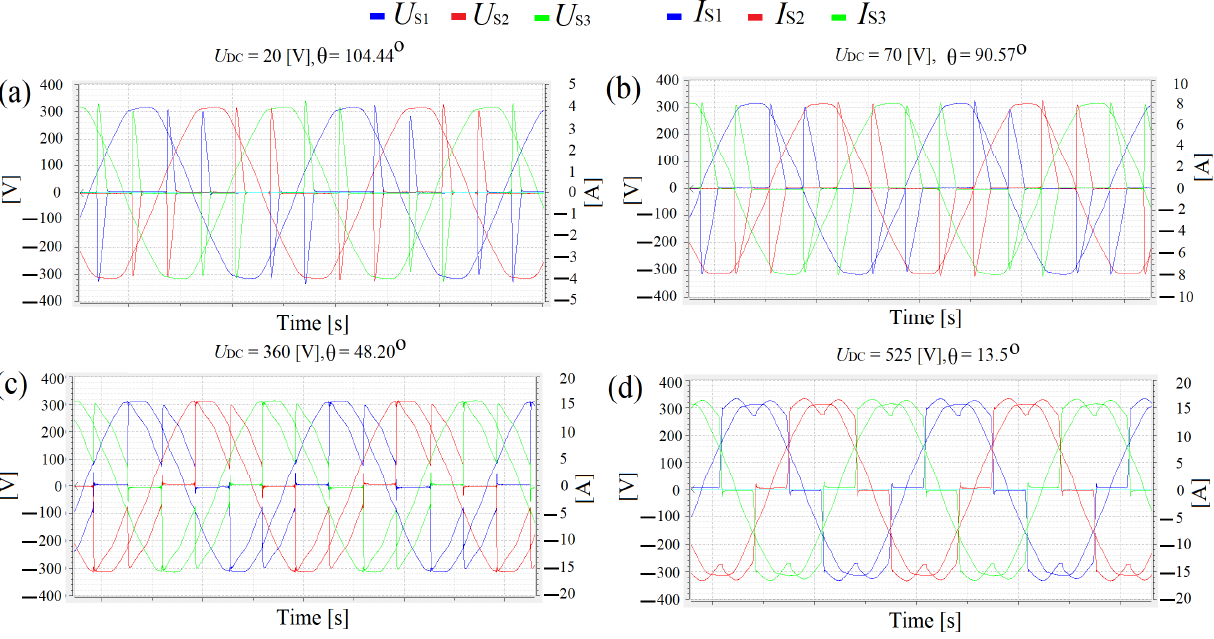
Figure 5. Examples of the measured PCC phase voltage and current for different values of DC voltage and firing angle: ( a ) U DC = 20 V; ( b ) U DC = 70 V; ( c ) U DC = 360 V; ( d ) U DC = 525 V. U L-L —line-to-line AC voltage; U DC average voltage at the rectifier DC